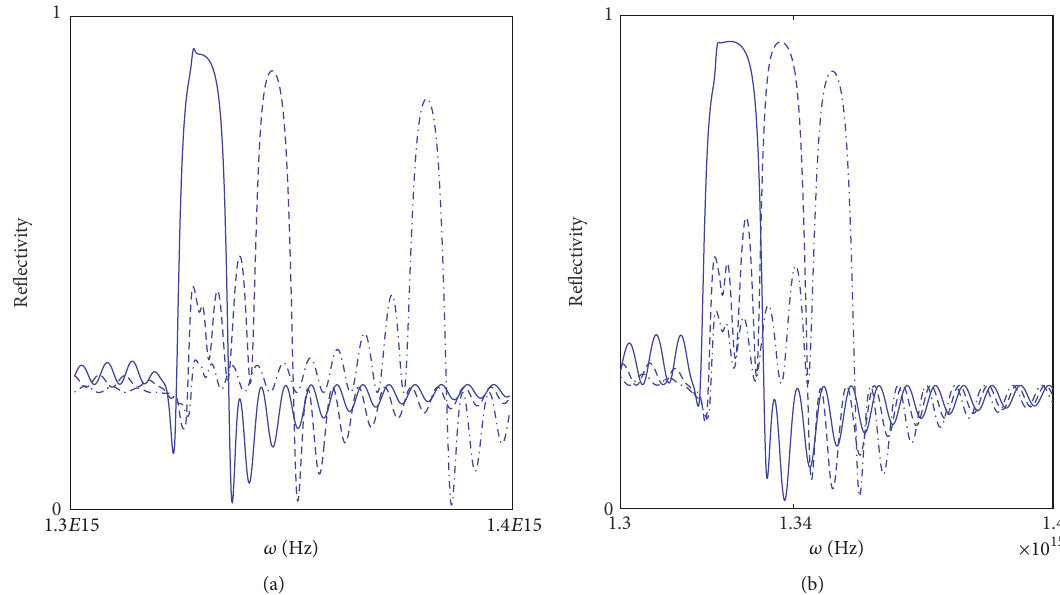
Figure 7: (a) Reflectivity of 200-periodic InGaAs/GaAs quantum well for 𝜃 = 0 ∘ (solid line), 𝜃 = 30 ∘ (dashed line), and 𝜃 = 60 ∘ (dashed-dot line). (b) Effect of width error on the switch performance. Solid line shows the reflectivity with no error. Dashed line shows 1nm error of both quantum barrier and well width on the reflectivity. Dashed-dot line shows 2 nm error of quantum barrier and well width on the reflectivity.